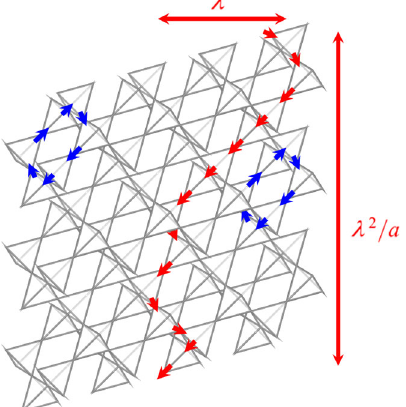
FIG. 2. Nonwinding loop (blue arrows) and string (red arrows) that can be flipped by winding loops of this length. The winding- loop move leads to a topological-sector fluctuation. The string (long red arrows) illustrates the effective finite-size system sampled by neutrons, with wave-vector transfer of amplitude j q j ¼ 2 (cid:2)=(cid:3)